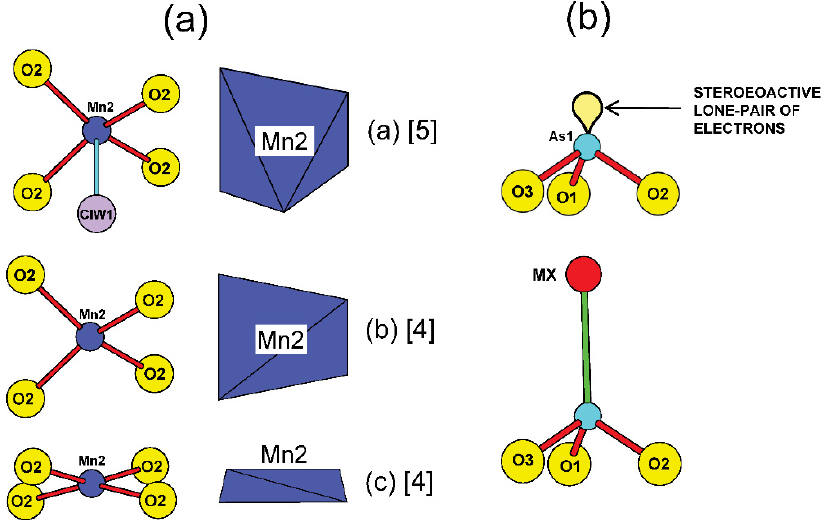
Figure 2. ( a ) Local coordinations of Mn2 (explanation in text). ( b ) Coordination of As atom, depict- lone-pair electrons and coordination to MX in partly occupied ing lone-pair electrons and coordination to MX in partly occupied site.